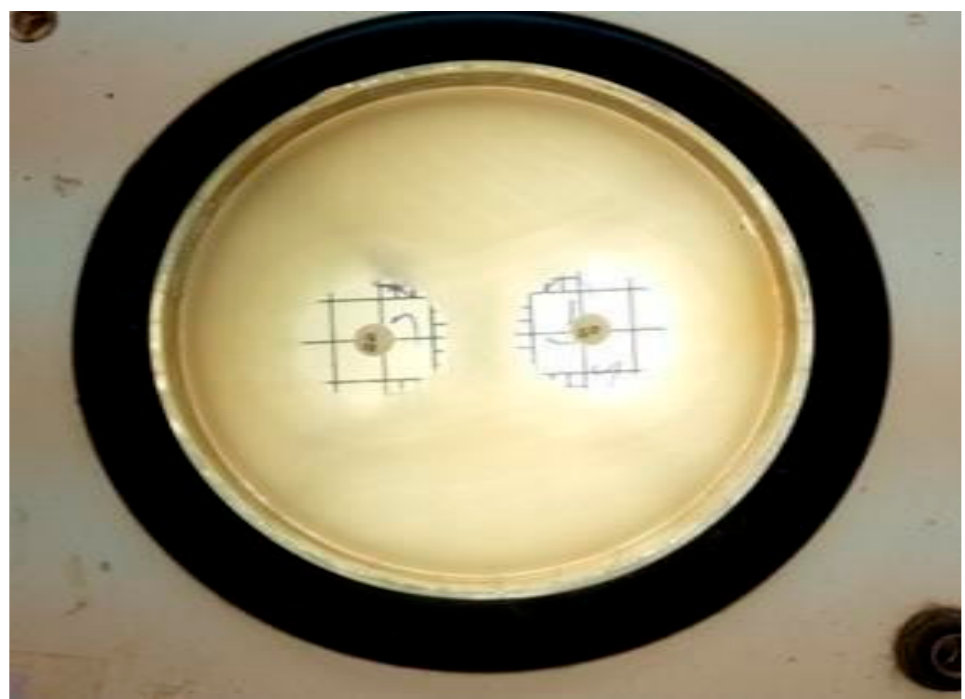
Figure 4. Standard Gentamycin on Staphylococcus aureus at 10mcg in duplicate at ZOI of 22.2 mm.